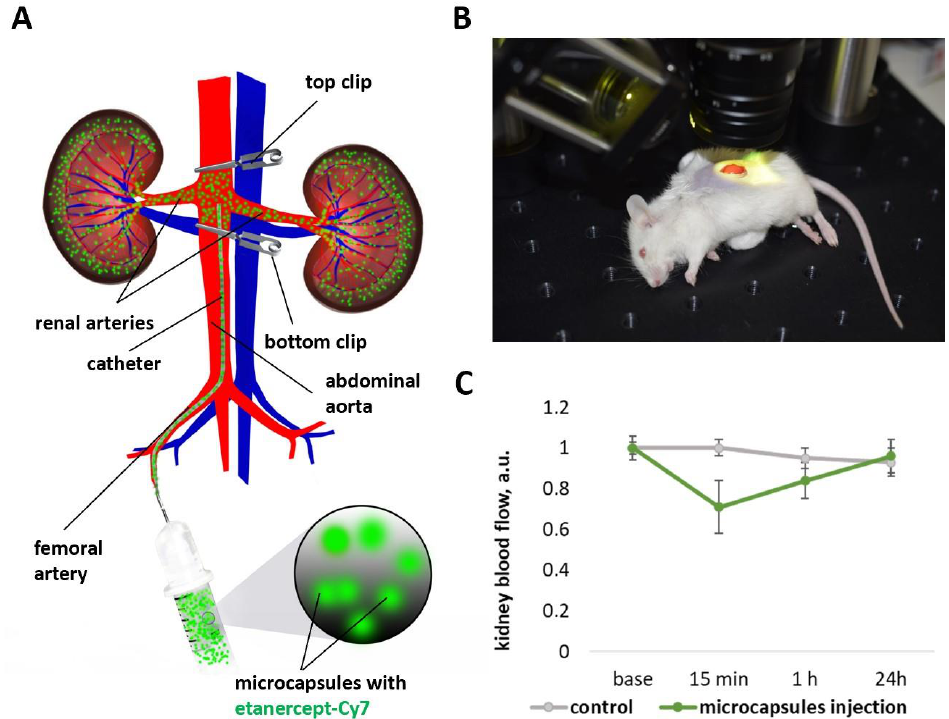
Figure 2. General scheme of the microcapsules injection into the renal arteries through the abdominal aorta ( A ). Measurement of mouse kidney blood flow using a laser speckle imaging system ( B ). Dynamics of kidney blood flow before, 15 min, 1 h, and 24 h after the microcapsules’ intra-arterial injection ( C ).